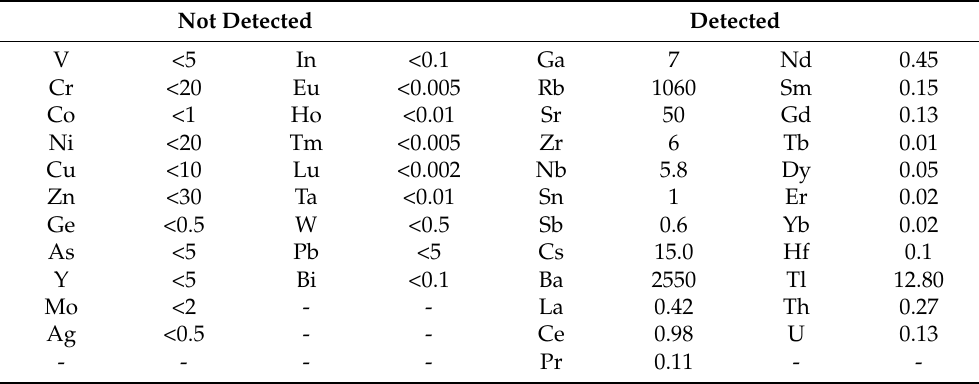
Table 4. Trace elements from adularia sample #1 from La Valenciana mine, Guanajuato, Mexico. All elements in µ g · g − 1